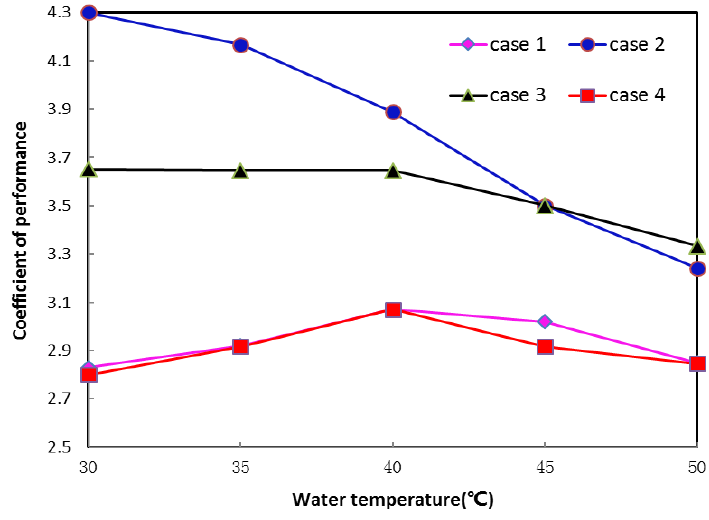
Figure 12. COPs at different evaporator water fluxes.